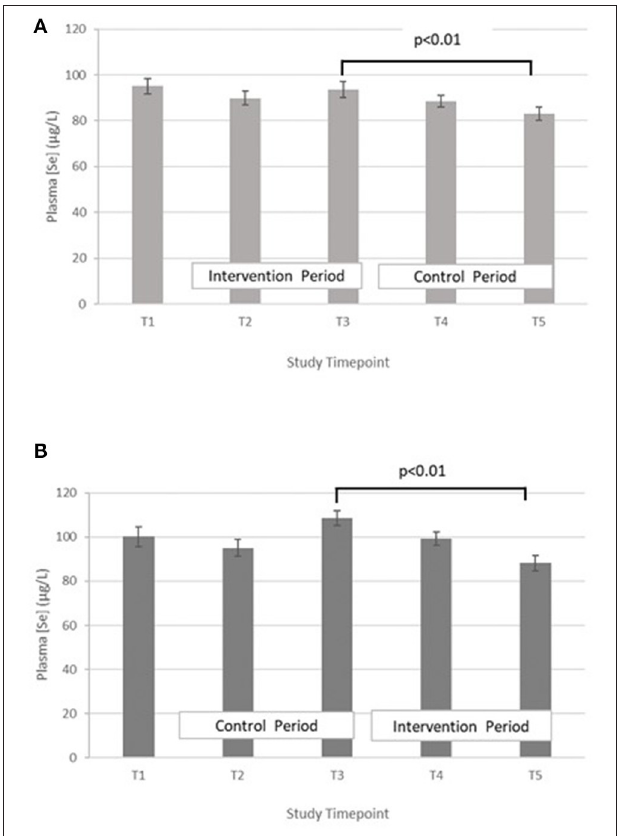
FIGURE 3 | (A) Plasma selenium concentration measured in Group A at baseline (T1), week 4 of period 1 (T2), week 8 of period 1 (T3), week 4 of period 2 (T4) and week 8 of period 2 (T5). Bars indicate estimated marginal means with standard error. (B) Plasma selenium concentration measured in Group B at baseline (T1), week 4 of period 1 (T2), week 8 of period 1 (T3), week 4 of period 2 (T4) and week 8 of period 2 (T5). Bars indicate estimated marginal means with standard error.